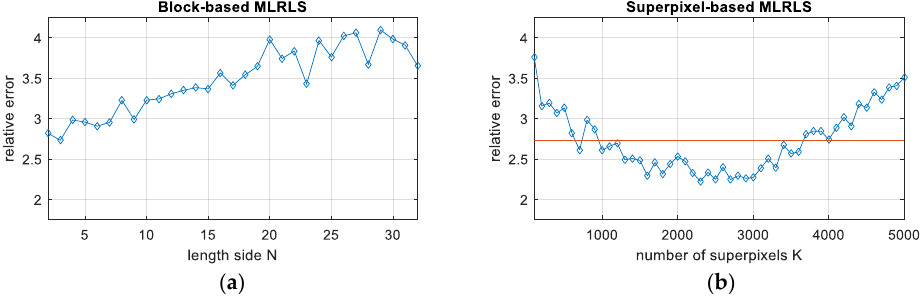
Figure 5. The relative errors of the SI noise: ( a ) the block-based MLRLS and ( b ) the superpixel-based MLRLS.